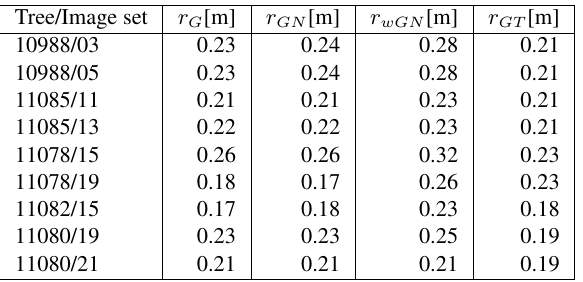
Table 1: Estimated radii with the Gander method ( r G ), unweighted Gauss-Newton ( r GN ), weighted Gauss-Newton ( r wGN ) and measured ground truth ( r GT ). Tree/Image